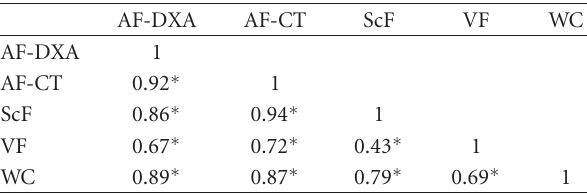
Table 3: Pearson’s correlations between AF-DXA, AF-CT, ScF, VF, and WC after weight loss